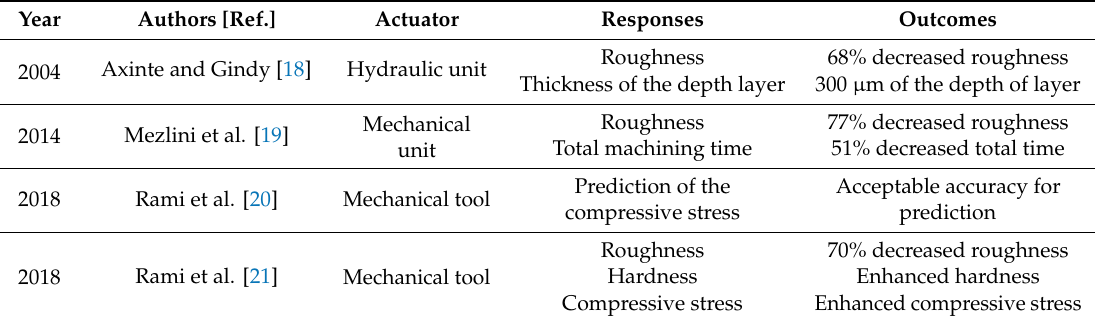
Table 1. Summary of published works related to turning-burnishing